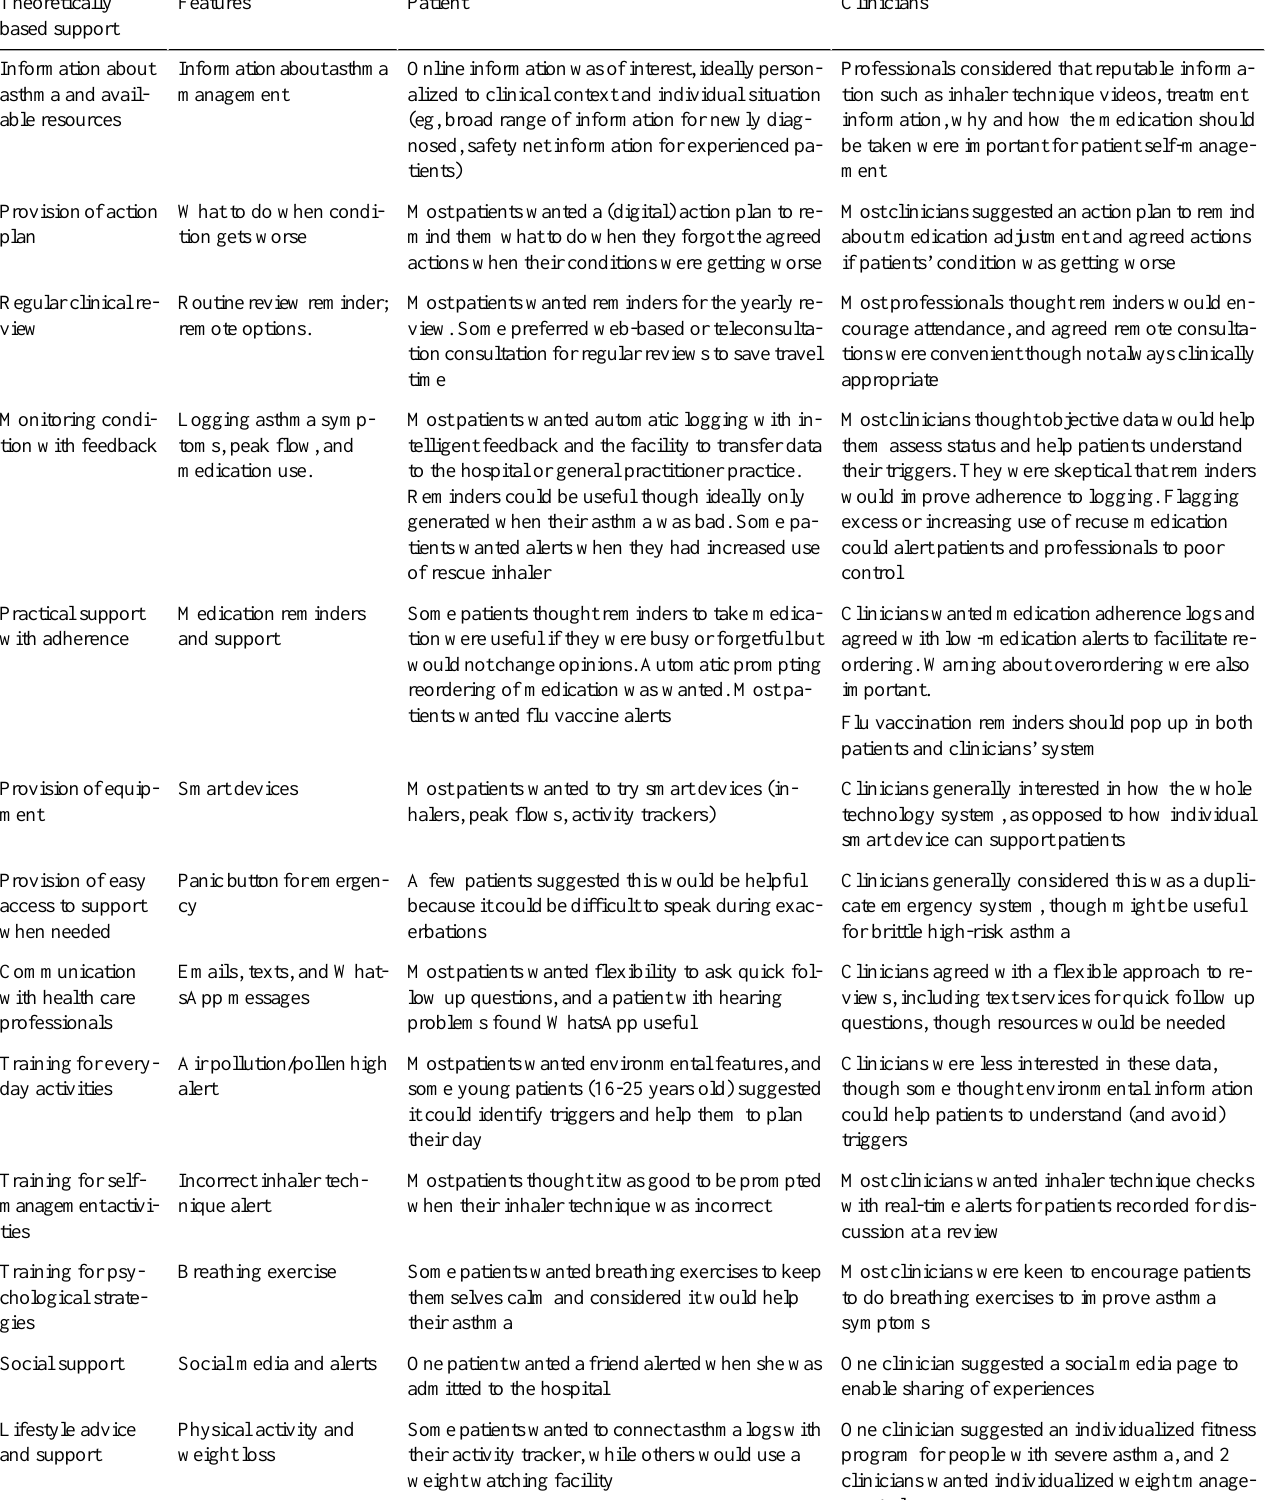
Table 4. Summary of the potential usefulness of features mapped to the PRISMS taxonomy [5].